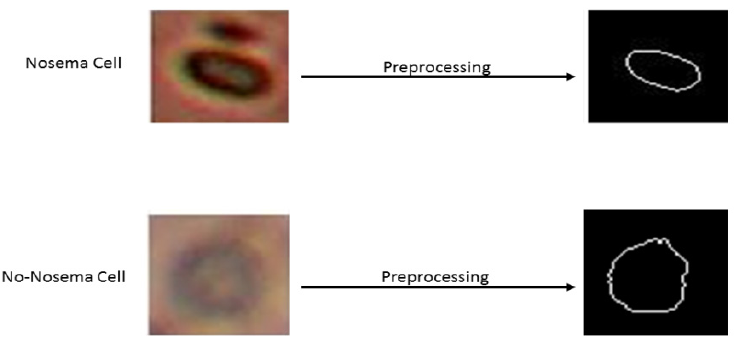
Figure 3. Shape results of two examples before and after preprocessing. The first sample is Nosema and the second is non Nosema object.